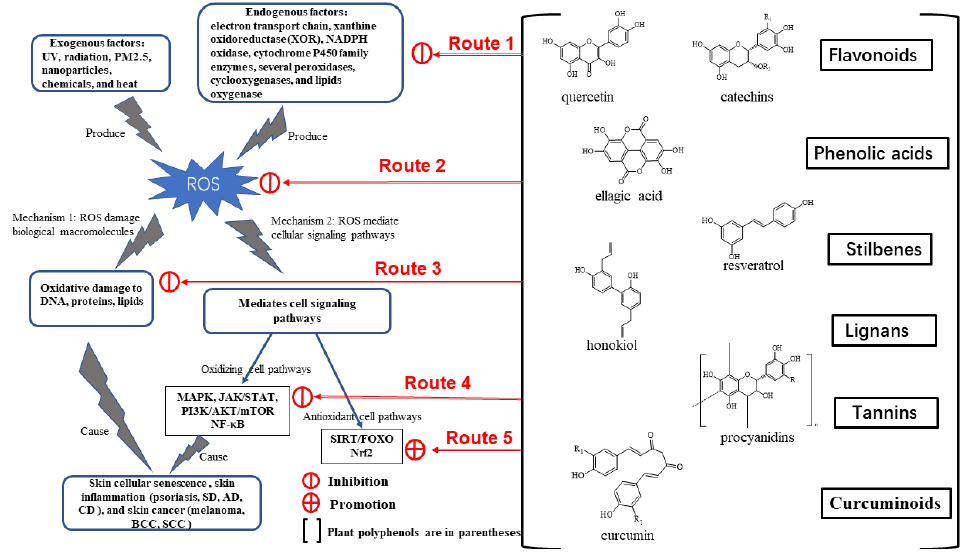
Figure 3. The regulatory mechanism of plant